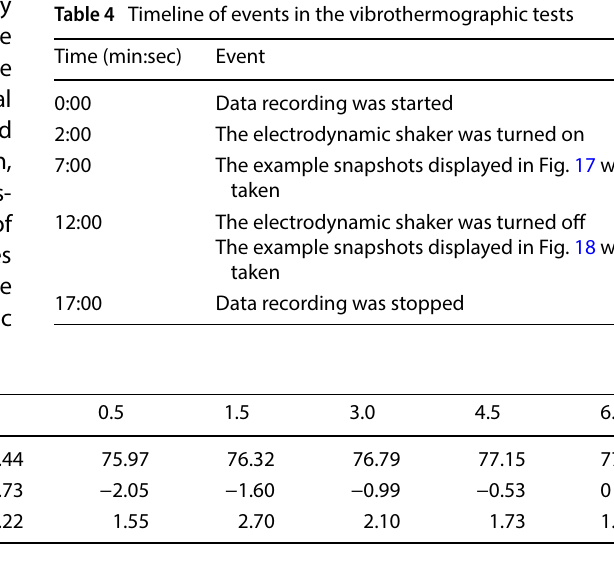
Table 4 Timeline of events in the vibrothermographic